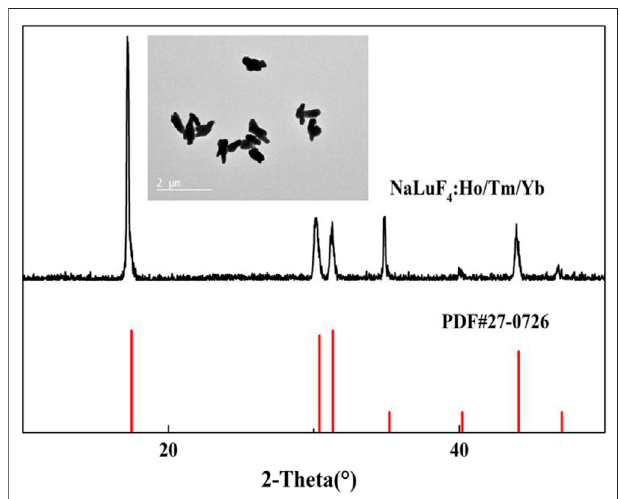
FIGURE 1 | XRD patterns of NaLuF 4 : Ho 3+ , Tm 3+ , and Yb 3+ phosphors (the inset displays the TEM image of the